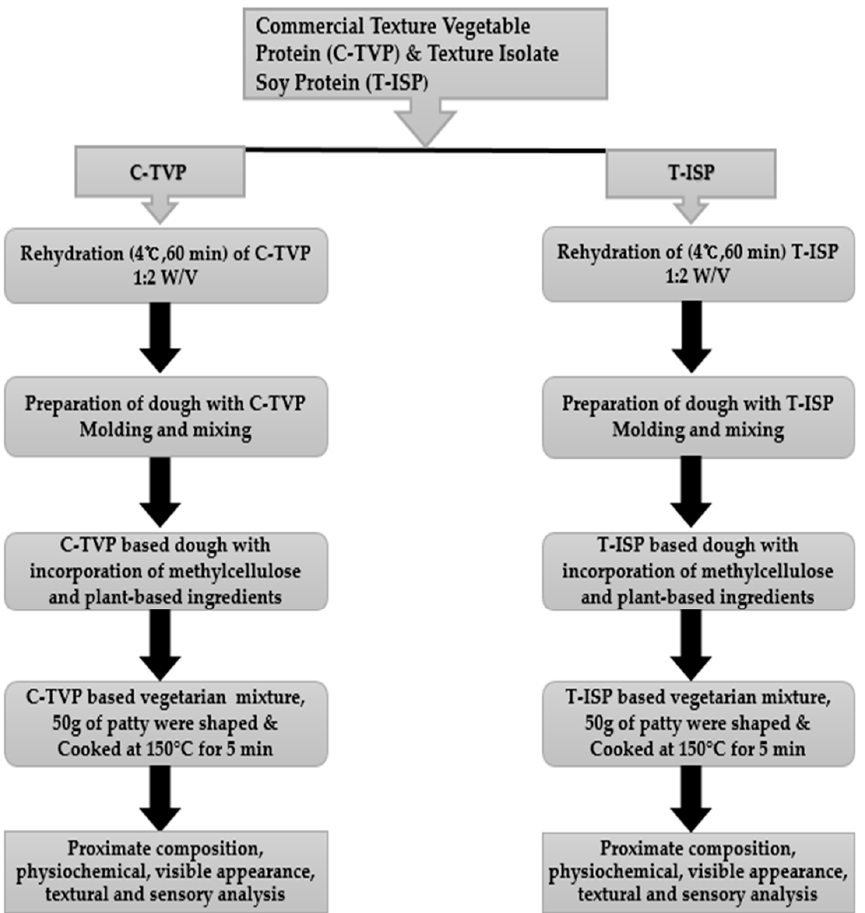
Figure 1. Flow diagram for manufacturing the meat analog. C-TVP: Commercial textured vegetable protein. T-ISP: Textured isolate soy protein. PBMA: Plant-based meat analog.